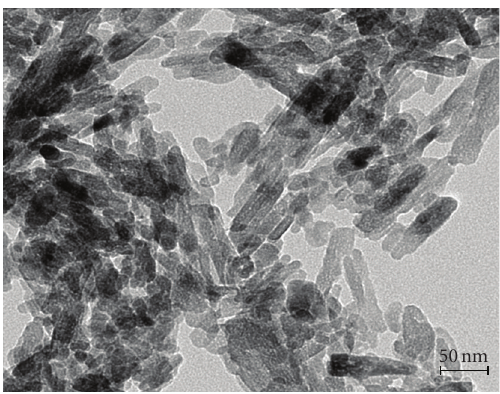
Figure 9: TEM photo of nano Hydroxyapatite prepared under primarily optimized conditions.